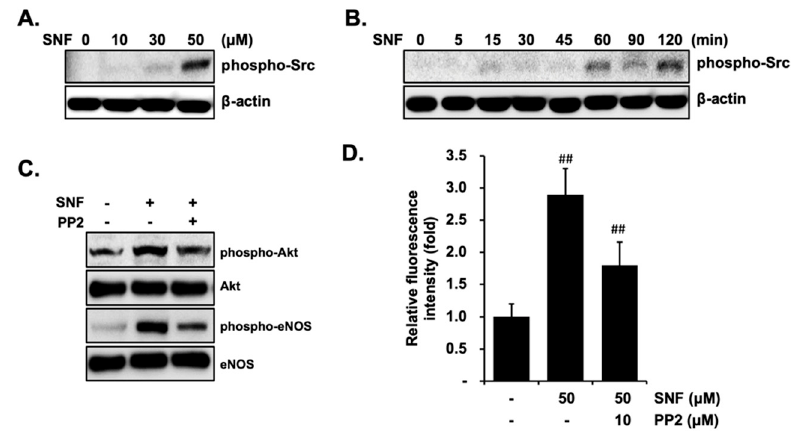
Figure 5. Src kinases are involved in SFN-induced eNOS phosphorylation via PI3K/Akt activation in EA.hy926 cells. Cells were treated with various concentrations of SFN for 1 h ( A ) or 50 μ M SFN for the indicated time points ( B ). The cell lysates were determined via Western blot using primary antibodies to Src, phosphorylated Src or actin. Cells were pretreated with 10 μ M PP2 prior to treatment with or without 50 μ M SFN. Cell lysates were examined by Western blot using primary antibodies to phosphorylated Akt, Akt, phosphorylated eNOS or eNOS ( C ), NO production was quantified using an NO measurement kit ( D ). The blots are representative of three independent assays. ## p < 0.01 versus control.